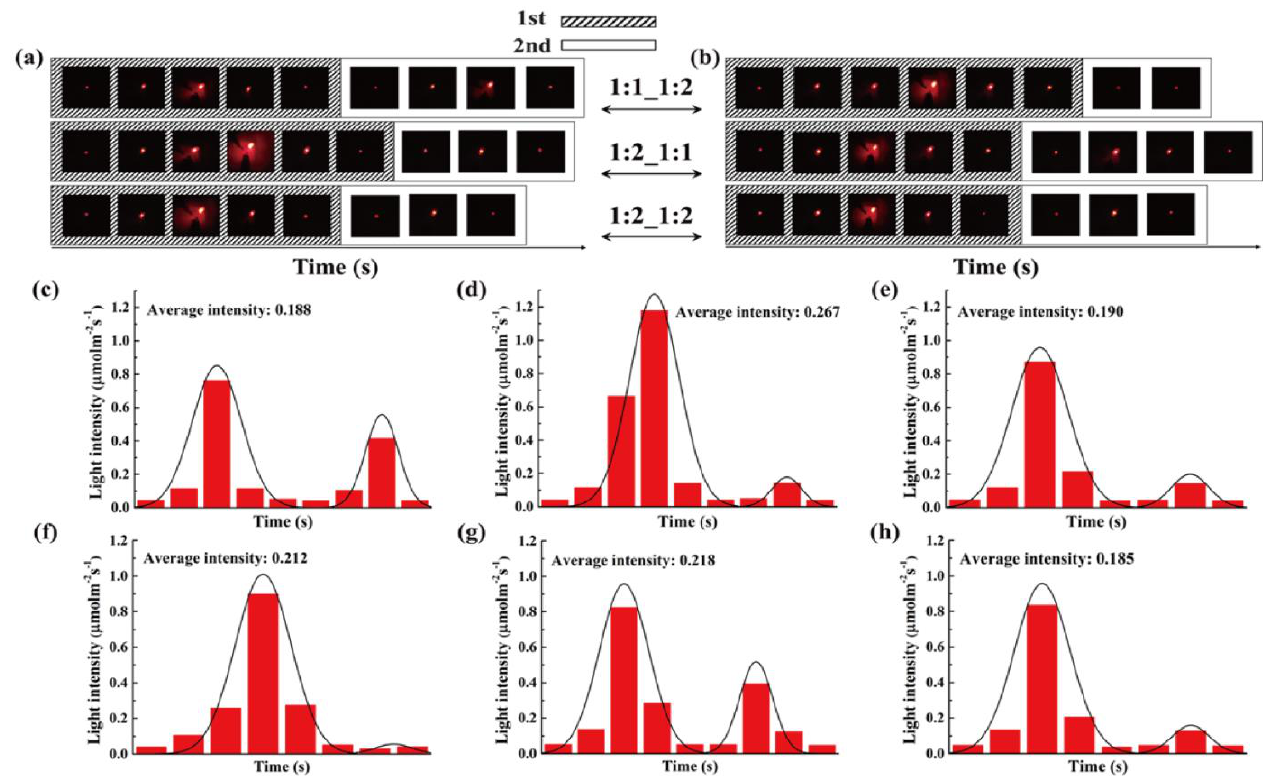
Figure 11. Optimization of components and temperature difference during the ( a ) heating process and ( b ) cooling process. Current curves of PCM composites during the ( c ) heating process and ( d ) cooling process.